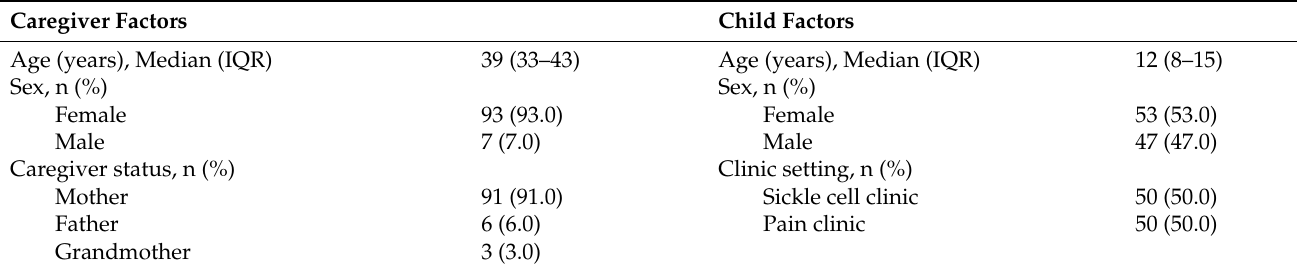
Table 1. Caregiver and Child